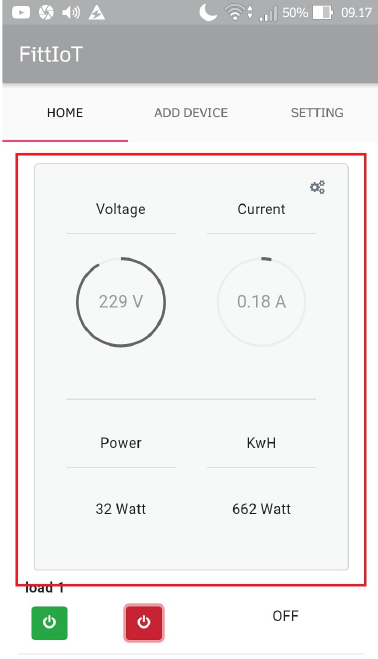
Figure 10. Display on smart panel applications when overloaded